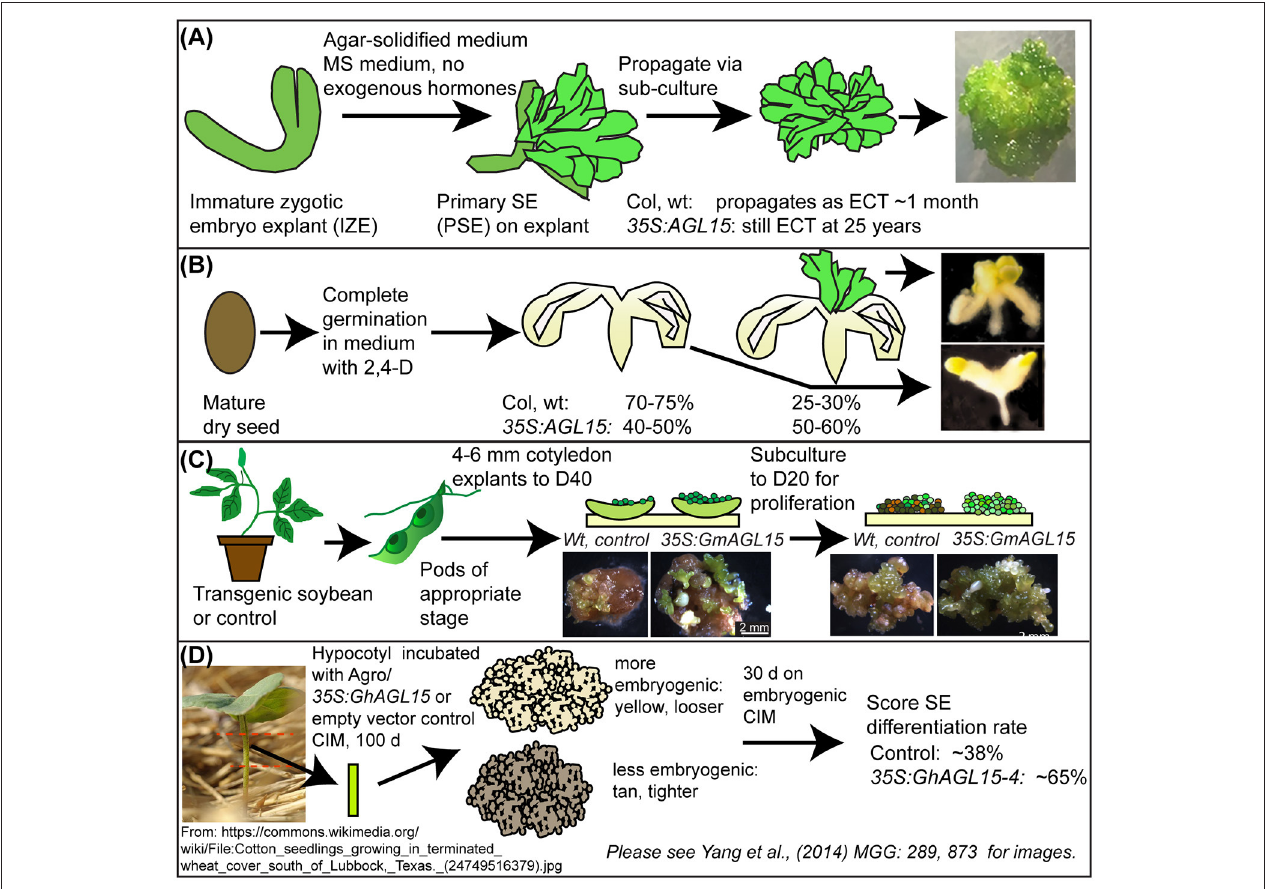
FIGURE 2 | Systems where manipulation of AGL15 levels have impacted on SE. Modified from Tian et al. (2020a). (A,B) two systems in Arabidopsis; (C) in soybean; (D) in cotton. D40, medium with 40 mg/L 2,4-D, D20, medium with 20 mg/L 2,4-D, CIM, callus induction